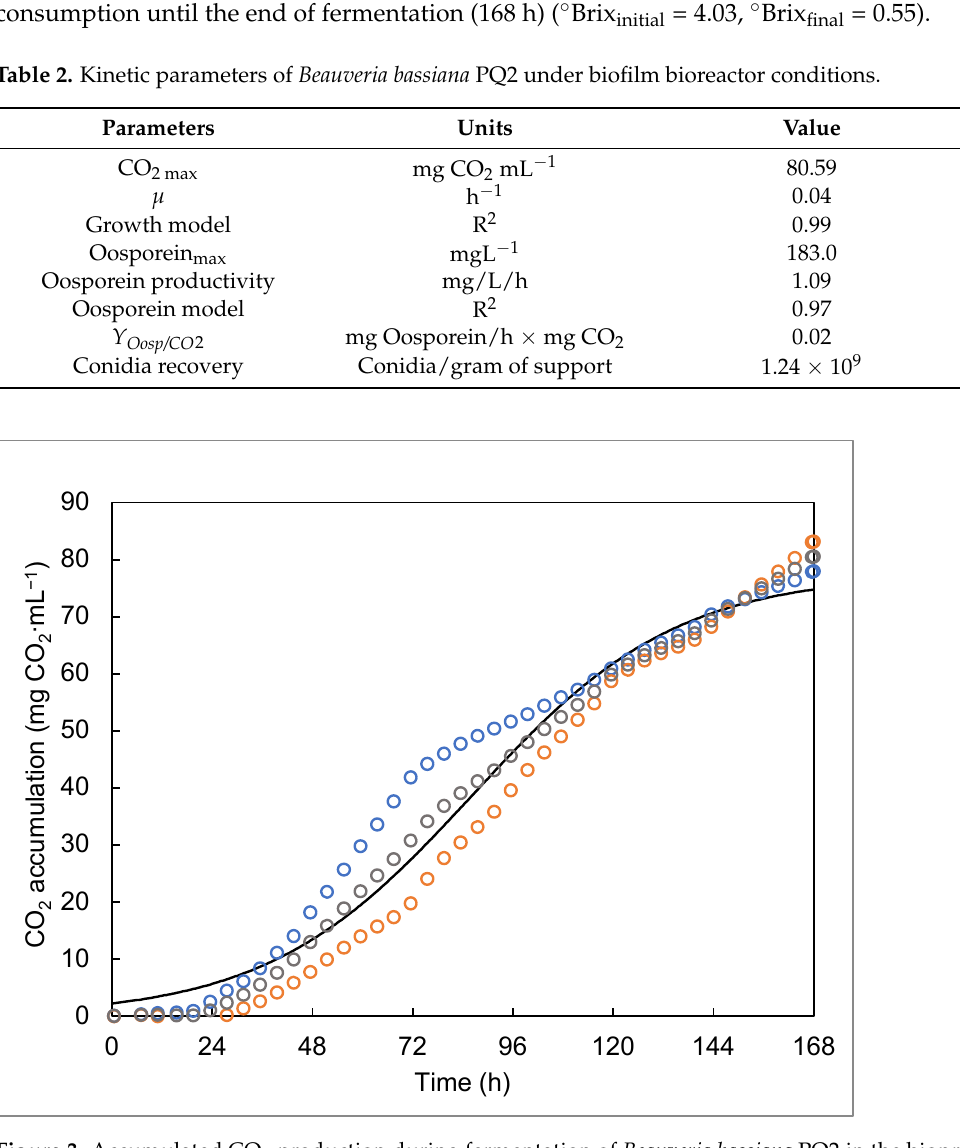
Figure 3. Accumulated CO 2 production during fermentation of Beauveria bassiana PQ2 in the biopro- cess for the production of aerial conidia and oosporein. Open circles are the experimental data, and the continuous line represents the data calculated by the model.